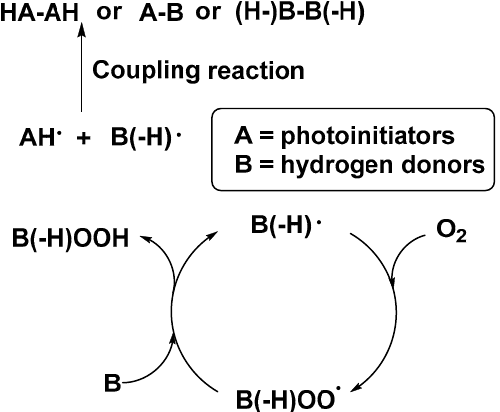
Scheme 3. Proposed interaction mechanism for photolysis of the photoinitiator in the absence of hydrogen donors.